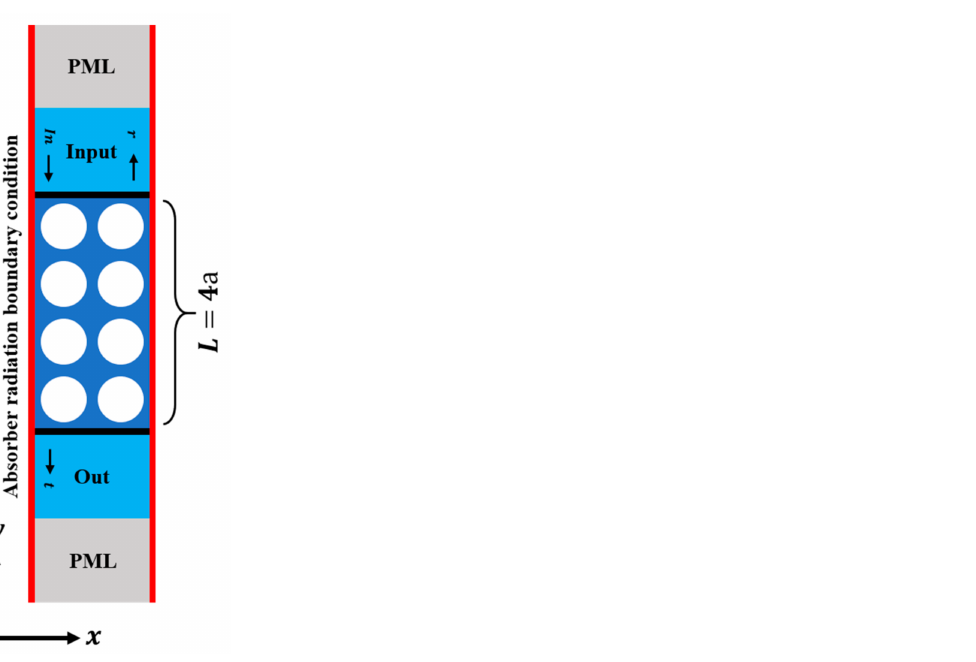
Figure 3. The schematic of a cell used for analysis of reflection coefficient